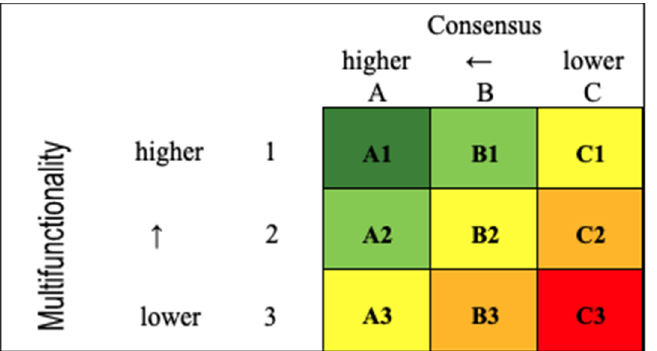
Figure 2. Land management practices ranking according to consensus (A to C) and multifunction- ality (1 to 3)